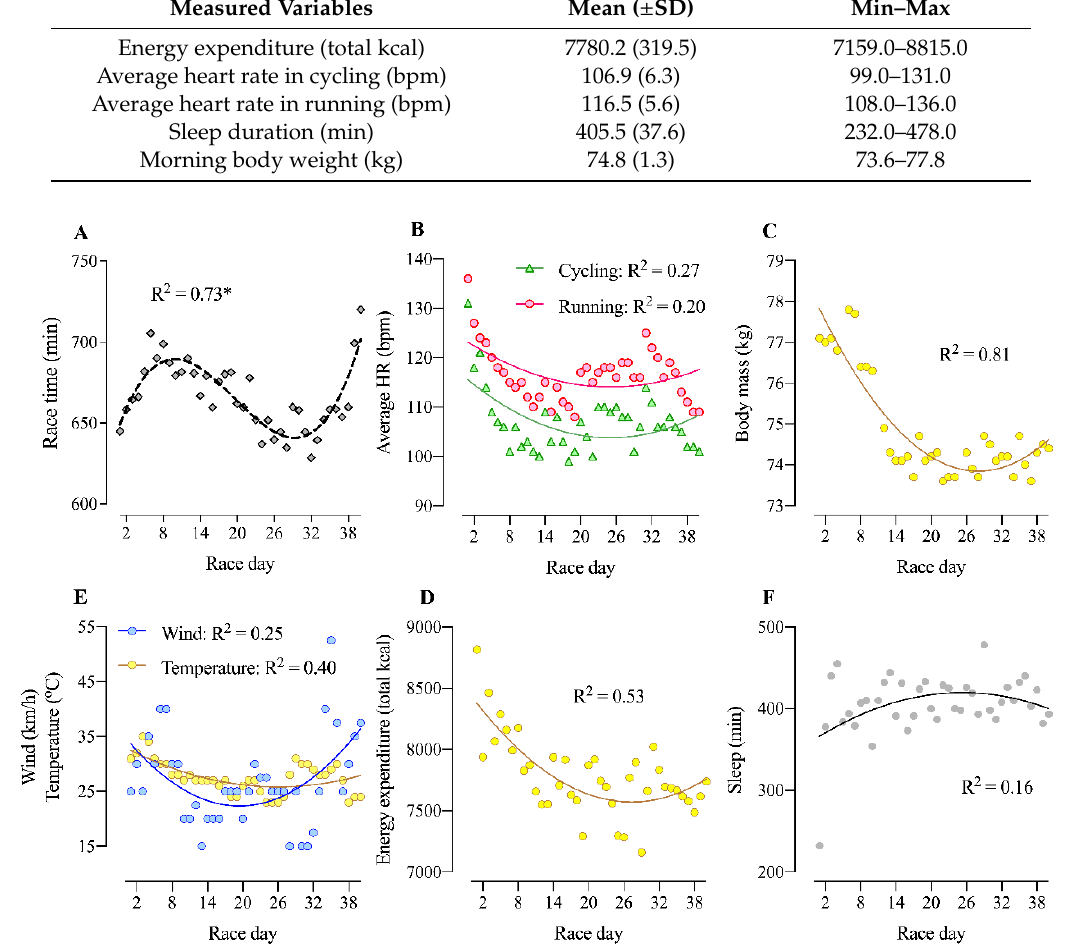
Figure 3. Non-linear regression for overall performance, weather and physiological variables in 40 Ironman-distance triathlons in 40 days. *: third-order polynomial fit; all other regressions were second-order polynomial fits. ( A ): overall performance; ( B ): average heart rate (HR) during cycling and running; ( C ): body mass; ( D ): wind speed and average temperature; ( E ): energy expenditure; ( F ): sleep minutes between race days.